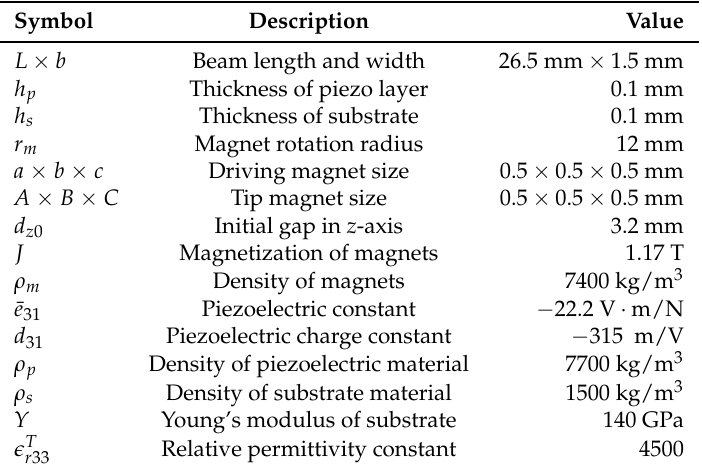
Table 1. Design parameters of the piezoelectric